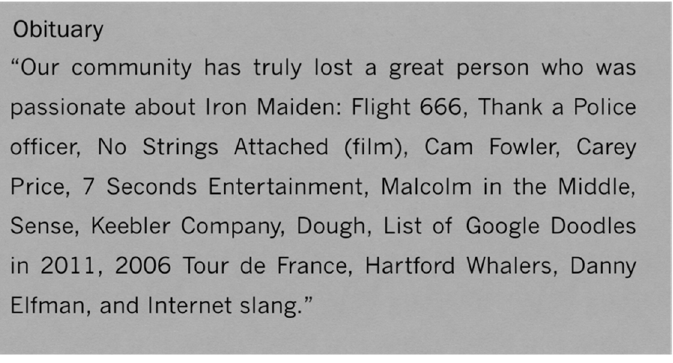
Figure 2. Student project, Facebook Obituary .